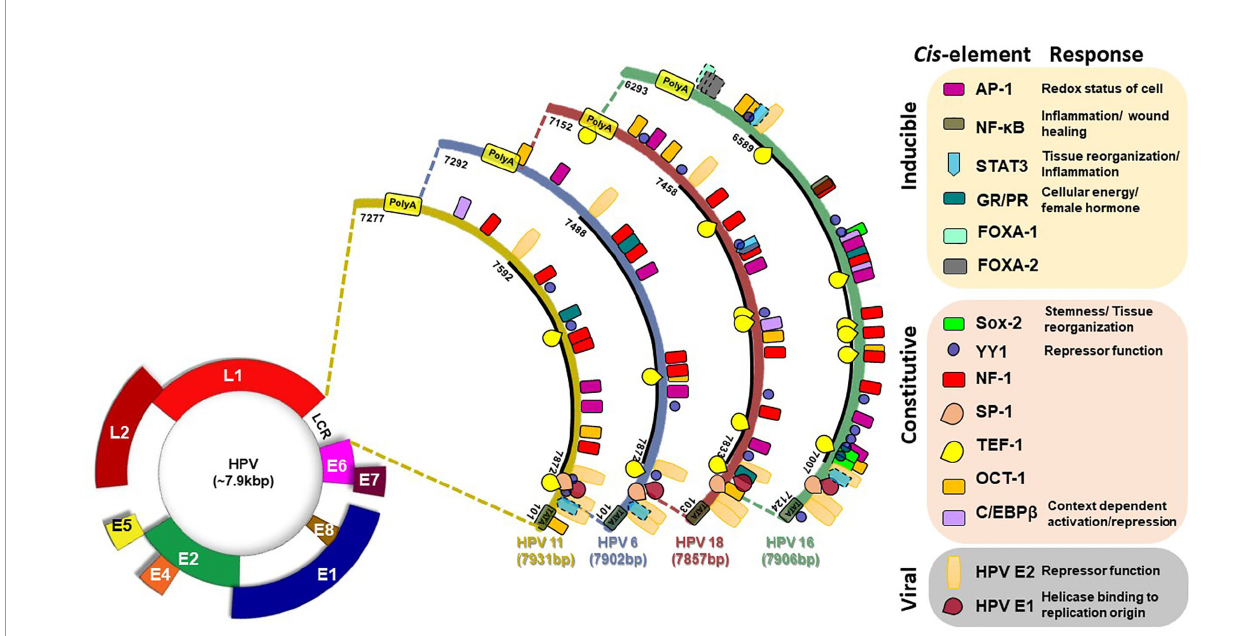
FIGURE 4 | Transcription factor binding site on LCR of HPV16 (831 bp), HPV18 (835), HPV6 (811 bp), and HPV11 (755 bp). Various consensus-binding sites for different transcription factors present on HPV LCR are represented as boxes. Solid line around the box indicate experimentally-validated site, broken line indicate putative site. Consensus-binding sites of AP-1 (Gloss et al., 1989; Chan et al., 1990; Chong et al., 1990; Nakshatri et al., 1990; Thierry et al., 1992; O ’ connor et al., 1995; O ’ connor et al., 1996; Wang et al., 2011), STAT3 (Arany et al., 2002), NF- k B (Fontaine et al., 2000), SOX-2 (Martinez-Ramirez et al., 2017), YY1 (O ’ connor et al., 1995; O ’ connor et al., 1996), NF-1 (Gloss et al., 1989; Chong et al., 1990; Nakshatri et al., 1990; O ’ connor et al., 1995), SP-1 (Gloss and Bernard, 1990), TEF1 (Ishiji et al., 1992; O ’ connor et al., 1995), Oct-1 (O ’ connor and Bernard, 1995; O ’ connor et al., 1995), FOXA1 (Sichero et al., 2012; Xi et al., 2017), on HPV16 (NC_001526.4), HPV18 (X05015.1), HPV6 (NC_001355.1), and HPV11 (M14119.1) have been reported in different studies and have been shown as per revised reference sequences in NCBI Nucleotide